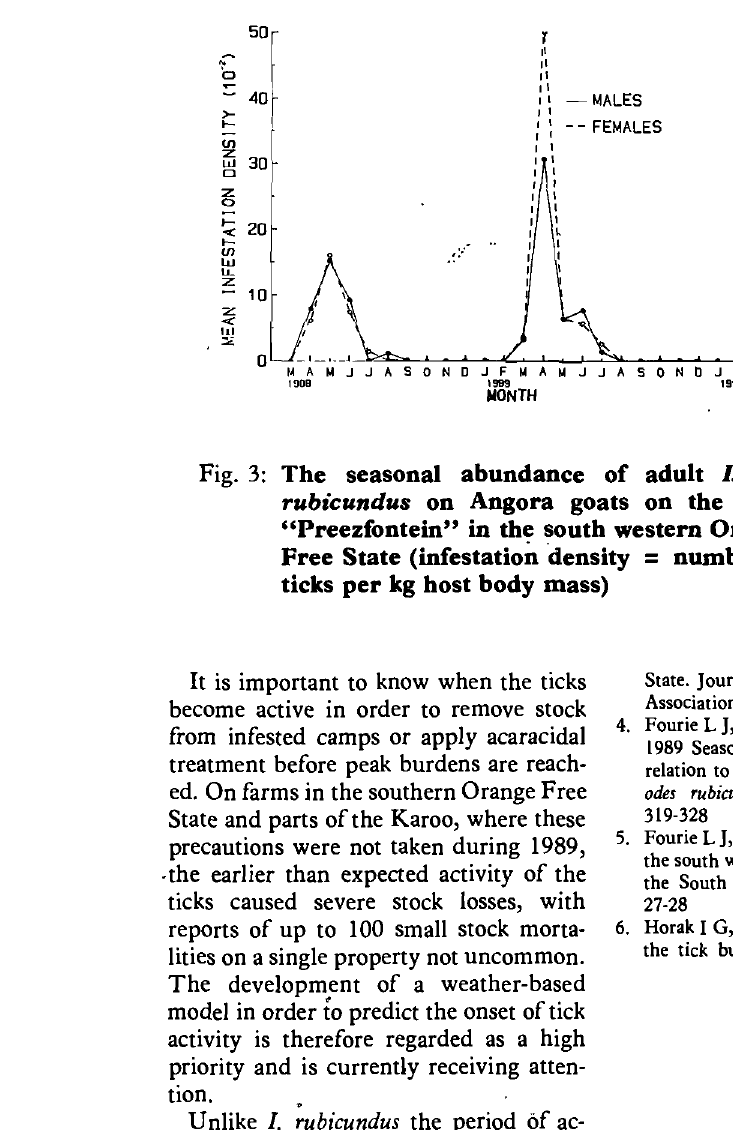
Tab1e2 : The relative abundance of the major tick species recovered from .goats, sheep and cattle on the farm "Preezfontein" Relative abundance (%) on: Tick species Goats Sheep Cattle Hyalomma marginatum